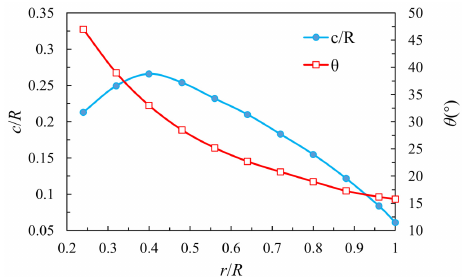
Figure 3. Chord and pitch distributions of the test propeller.